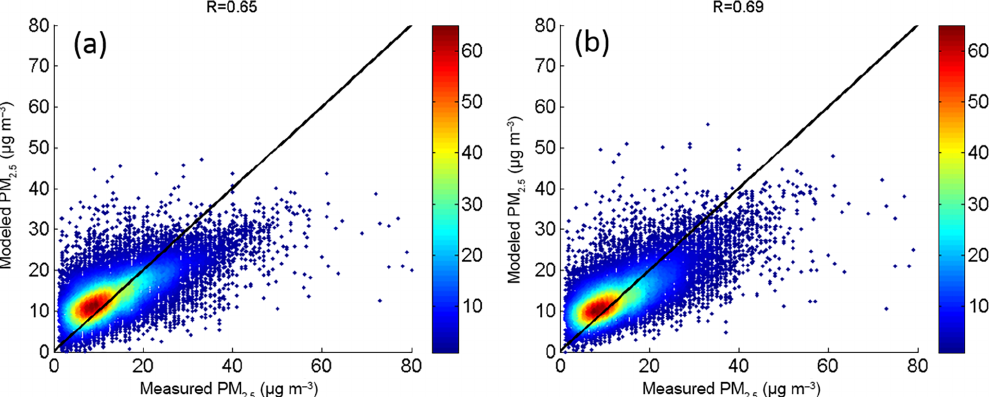
Figure 10. Same as Fig. 9 but with all meteorological variables taken into